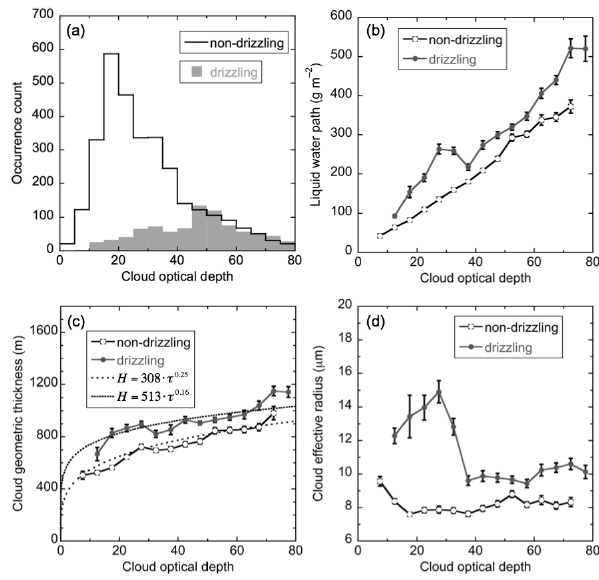
Figure 9. Same as Fig. 8, but with plots of cloud properties versus cloud effective radius. (b–d) omit bins of cloud effective radius with a sample size smaller than 25.